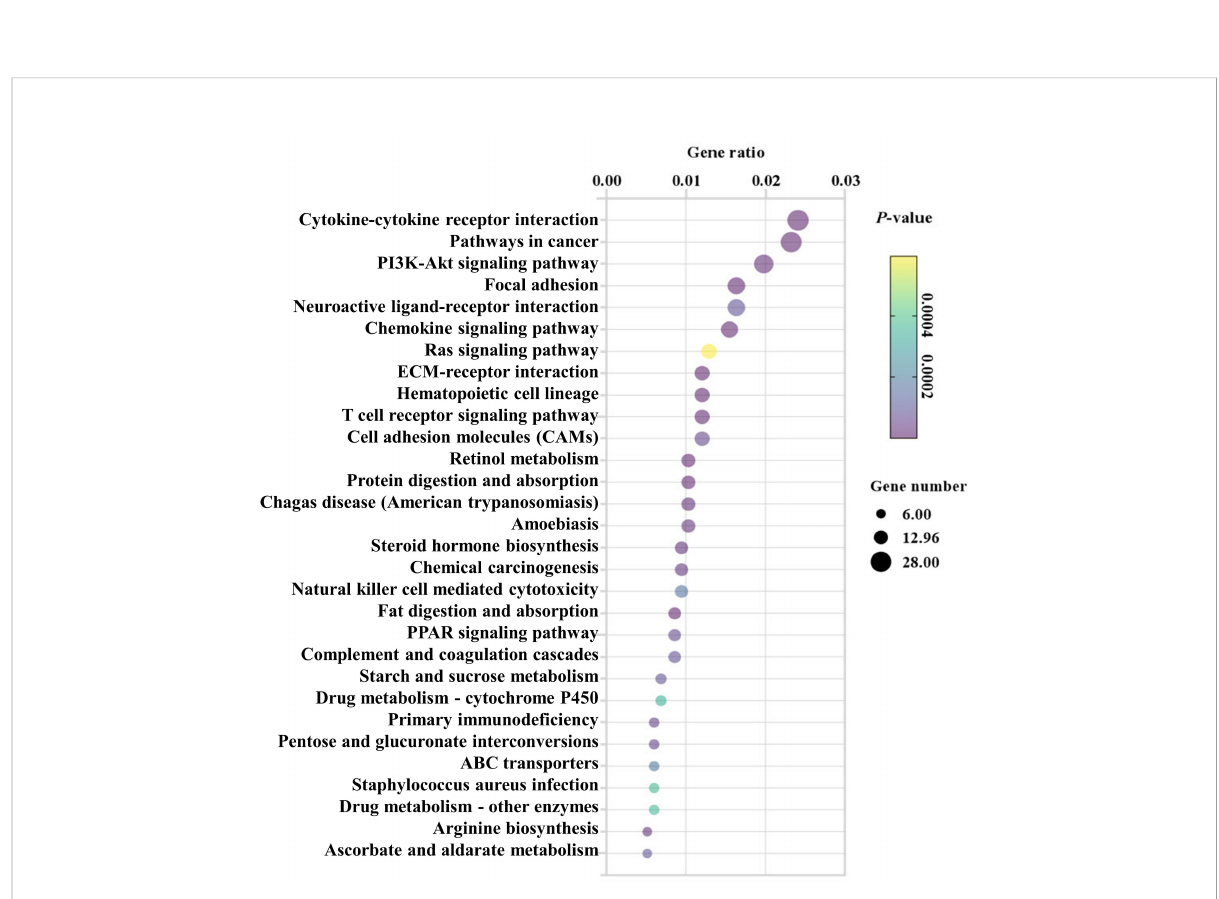
FIGURE 3 KEGG analysis (top 30) of the differentially expressed mRNAs in the colonic tissues post the protoscoleces of Echinococcus granulosus infection. Rich factor is the ratio of the differentially expressed gene number to the total gene number in a certain pathway. The color and size of the dots represent the range of the P -values and the number of DEGs mapped to the indicated pathways, respectively. The larger the point, the more genes involved in this pathway.